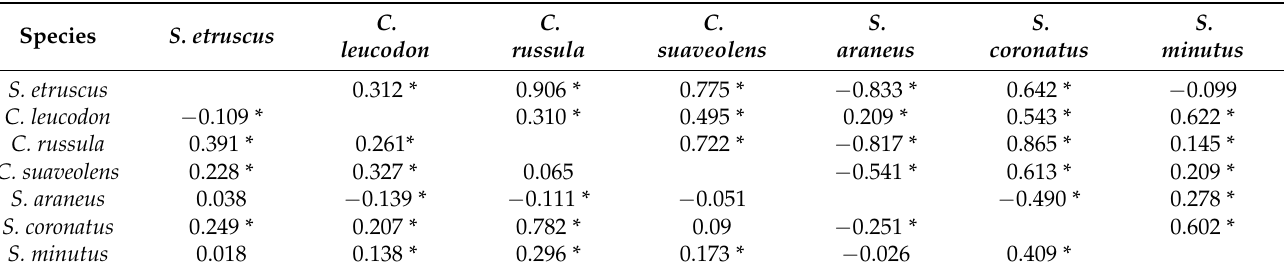
Table 1. Results using Pollock’s framework. Results above the diagonal are for environmental correlation. Results below the diagonal are for residual correlation. Environmental correlation is the correlation between species that is explained by the climatic variables included in the model. Residual correlation is the correlation that is not explained by any variable included in the